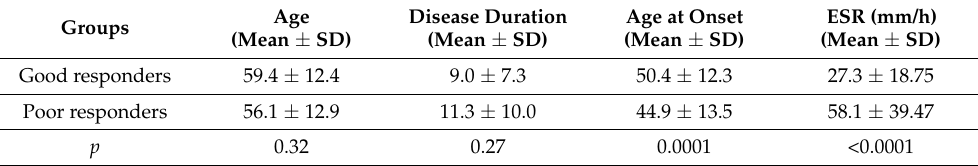
Table 2. Clinical characteristics in good responders and poor